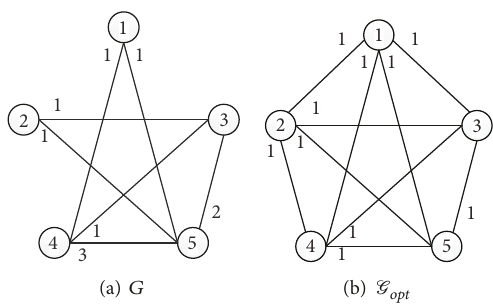
Figure 3: (a) Original system G ; (b) the largest convergence rate system G 𝑜𝑝𝑡 .